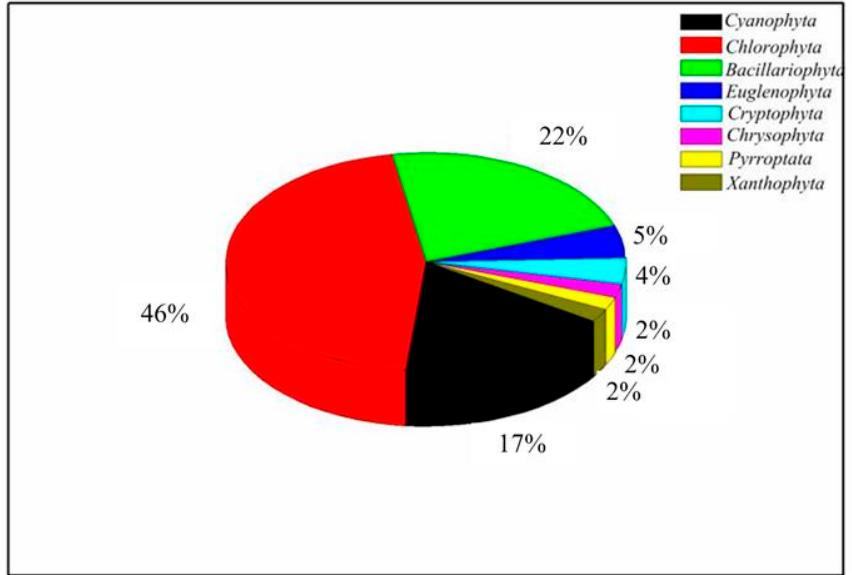
Figure 3. Phytoplankton species composition.